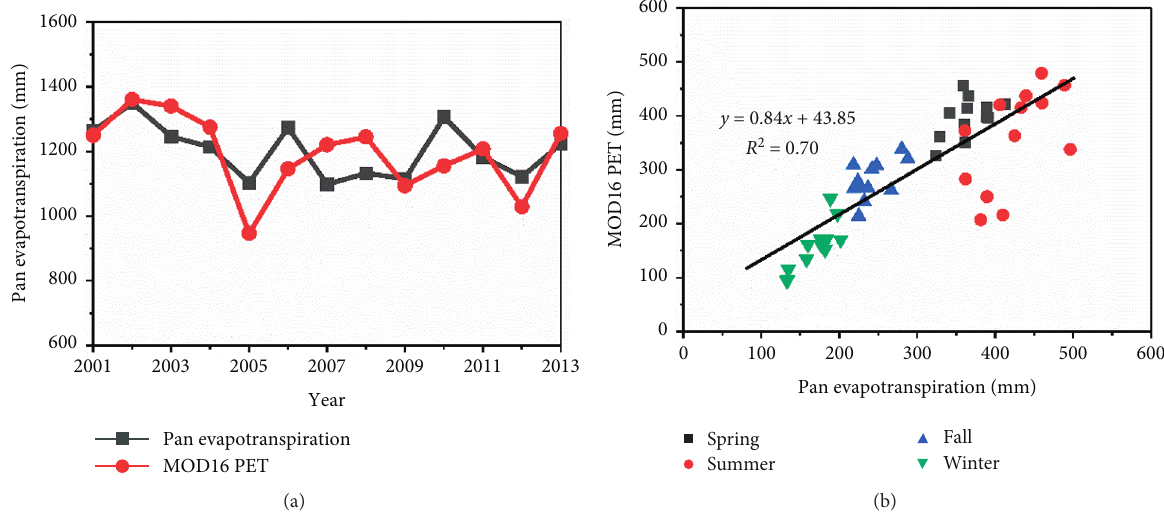
Figure 4: Consistency analysis of MOD16 PET data and pan